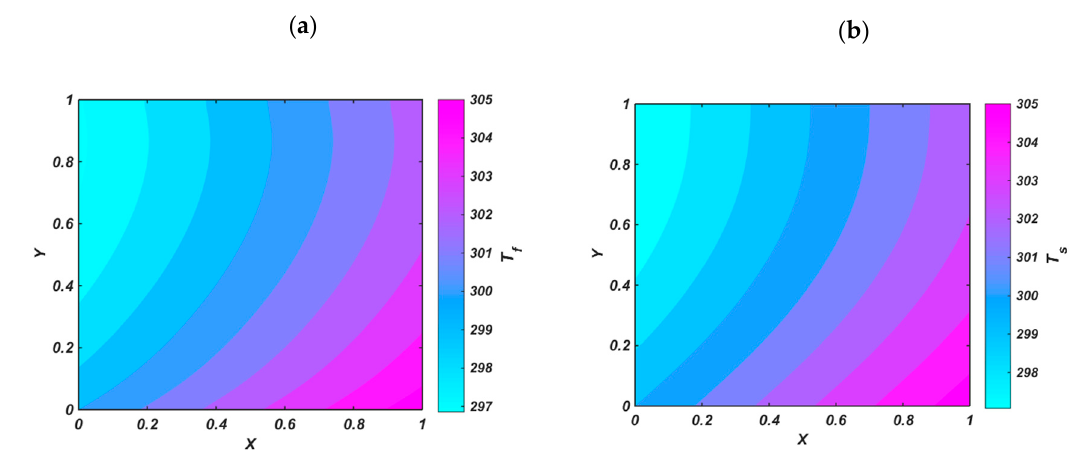
Figure 6. Temperature counters: ( a ) fluid phase and ( b ) solid phase.